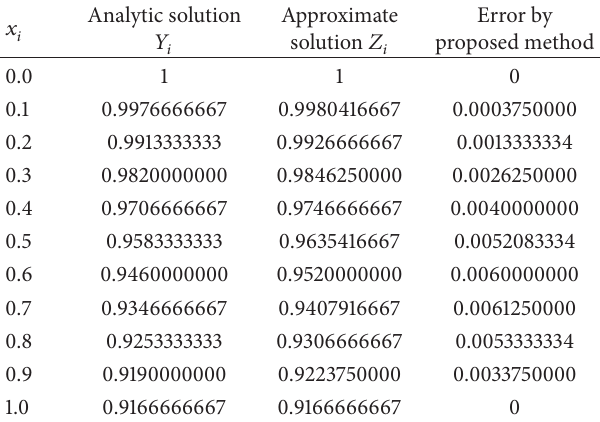
Table 4: Numerical results of Example 4: 𝑘 = 0 and ℎ = 10 −1 .